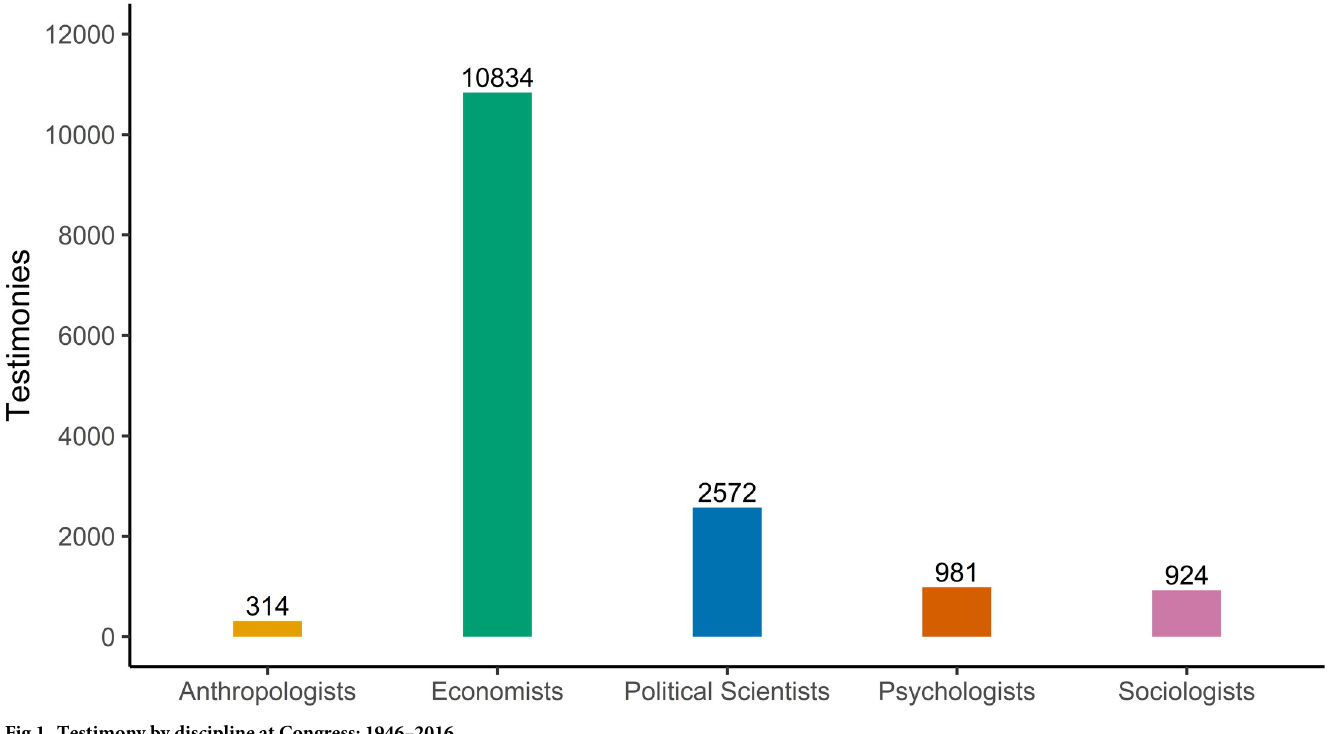
Fig 1. Testimony by discipline at Congress: